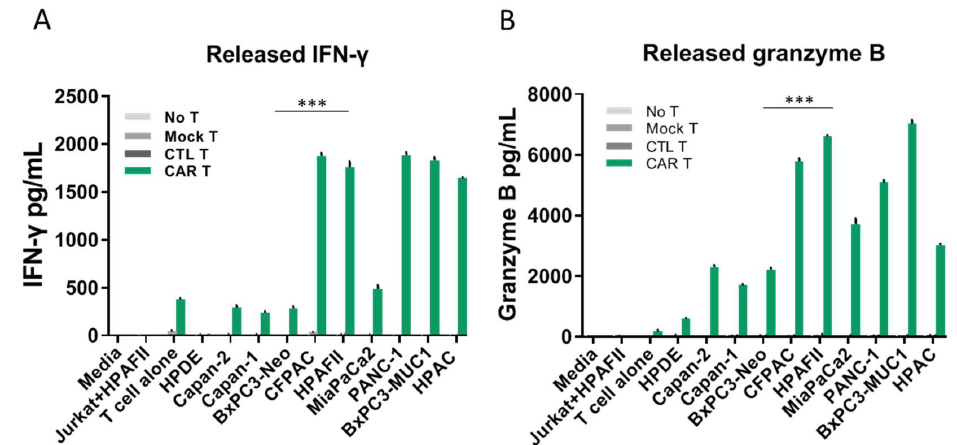
Figure 3. tMUC1-CAR-T cells produce IFN- γ and granzyme B upon activation and antigen recognition. The amount of released IFN- γ ( A ) and granzyme B ( B ) in the co-culture media of CAR T cells and cancer cells measured by sandwich ELISA. Controls include supernatant of (1) cancer cells alone, (2) Jurkat and HPAFII cells co-culture, (3) T cells alone, as well as (4) media alone. The cancer cells are ordered based on their MUC1 level from left to right (low to high MUC1). tMUC1-CAR T cells exposed to cancer cells produce significant amount of IFN- γ and granzyme B, while CTL T and mock T cells exposed to cancer cells produce negligible amount of IFN-y and granzyme B. CAR T cells exposed to normal epithelial cell line, HPDE, did not release noticeable amount of IFN- γ and granzyme B. Significance is determined by comparing CAR T vs. mock T groups for each cell line. Error bars, SEM. n = 4. Student’s t -test, *** p < 0.0005 for CAR T cells vs. mock T